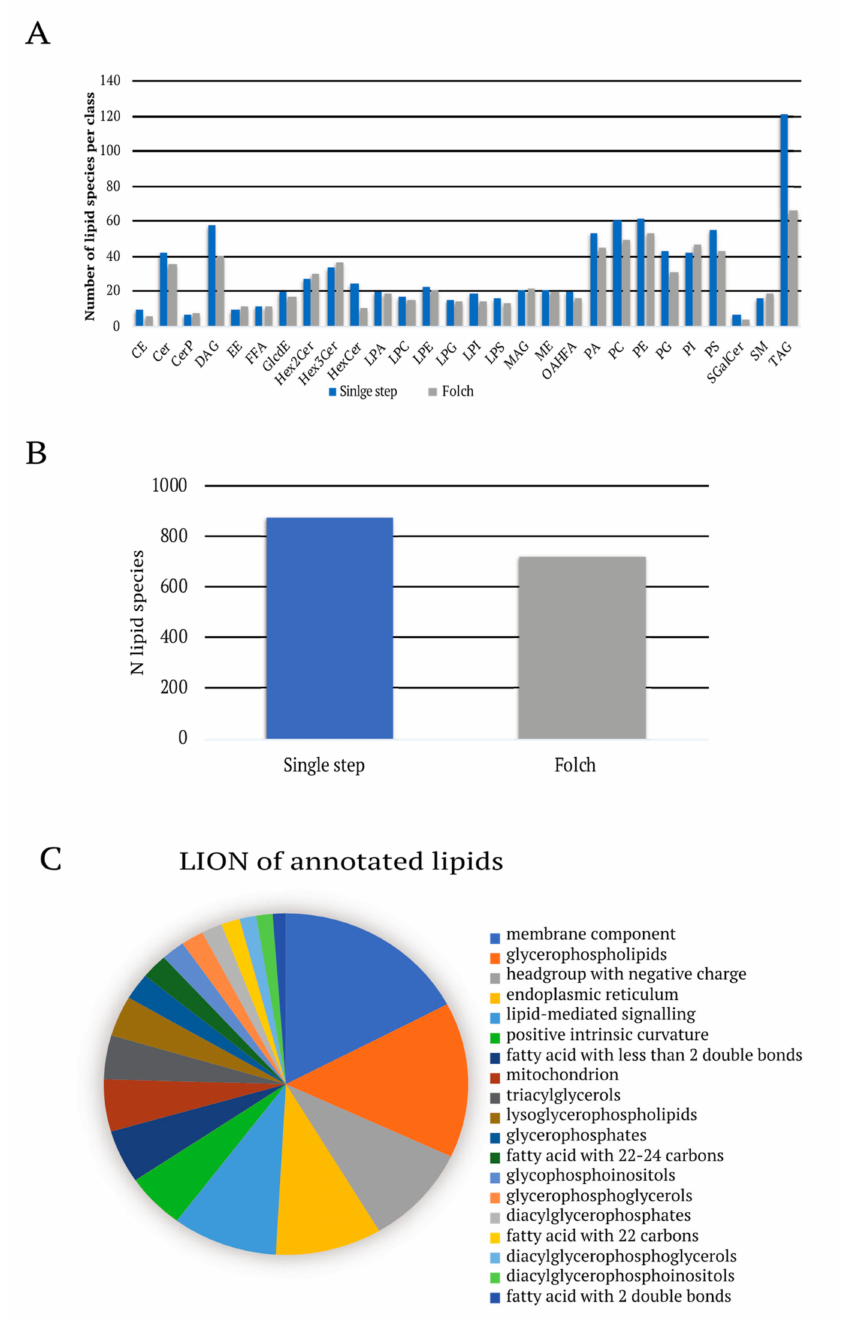
Figure 5. Lipidomic analysis with new lipids extraction method in IGR37cell line. ( A ) Lipids species identified per class in IGR37 cells with single-step and Folch extraction method. ( B ) Total number of lipid species identified in IGR37 cells with single-step and Folch extraction method. ( C ) Lipid ontology enrichment analysis performed with LION [35] of the lipid species identified in IGR37